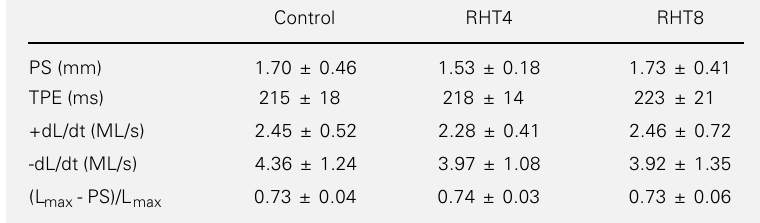
Table 3 - Isotonic contraction data. Data are reported as means ± SD for N = 10. PS, Peak shortening; TPE, time to peak shortening; +dL/dt, maximum velocity of isotonic shortening; -dL/dt, maximum ve- locity of isotonic relengthening; ML, muscle length; (L max - PS)/L max , relative variation of length; L max , muscle length at peak of developed tension; RHT4, renovascular hypertension for 4 weeks; RHT8, renovascular hypertension for 8 weeks (one-way analysis of variance and post hoc Tukey